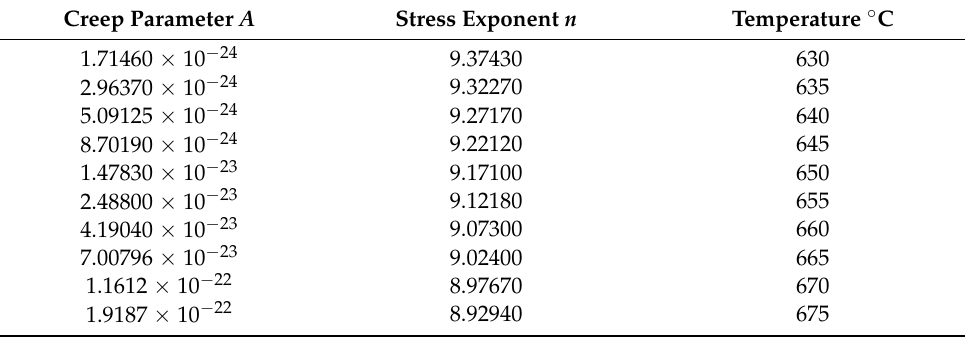
Figure 5. Material properties of isotropic material SS-316 [44]. Table 3. Material SS-316 constants for creep at temperatures 630–675 ◦ C, ω =